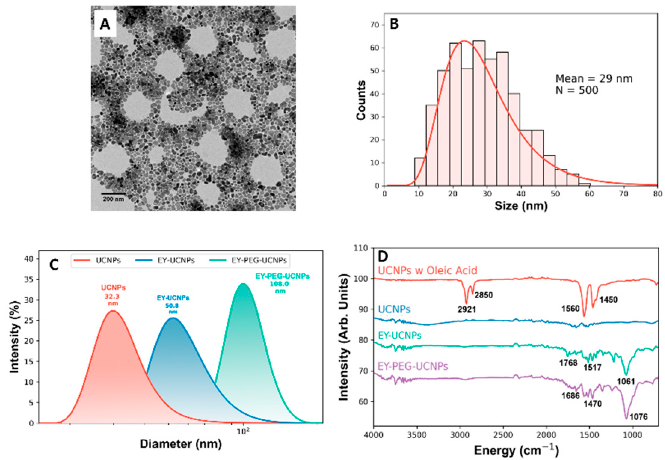
Figure 2. ( A ) TEM image of the UCNPs used in this work. ( B ) Particle size distribution histogram of the UCNPs. ( C ) Diameter distribution measured by DLS for UCNPs (red), EY-UCNPs (blue), and EY-PEG-UCNPs (green). ( D ) FTIR spectra of UCNPs, EY-UCNPs, and EY-PEG-UCNPs.